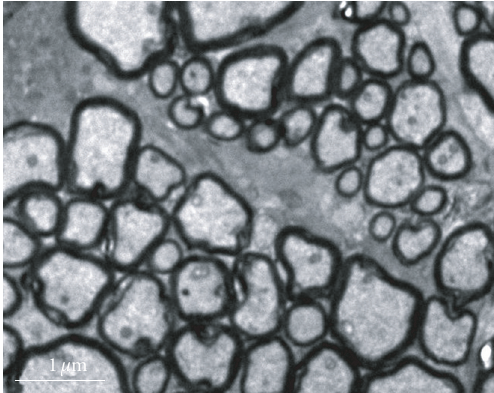
Figure 2: Shortly after suction 3 minutes, retinal nerve fiber layer and retinal ganglion cells changed sharply such as edema, every layer of rabbit retina is not in order (HE × 400).